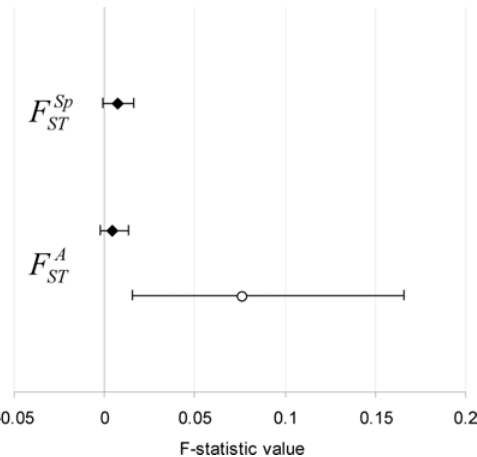
Figure 2. Genetic differentiation of Schistosoma japonicum among definitive host species F Sp population isolates. Error bars represent 95% confidence intervals estimated from 20 000 bootstraps.